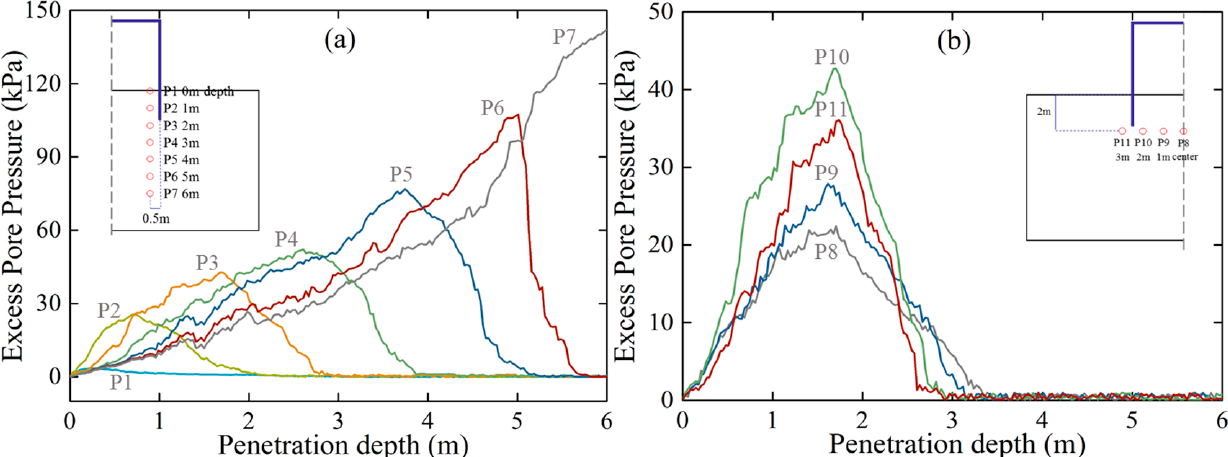
Figure 6. Excess pore pressure evolution with caisson jacked penetration depth at typical points within the soil: ( a ) Points P1 to P7 at 0 m to 6 m depths 0.5 m inside the caisson wall; ( b ) Points P8 to P11 at 0 m to 3 m horizontal distances from the center of the caisson at 2 m depth.